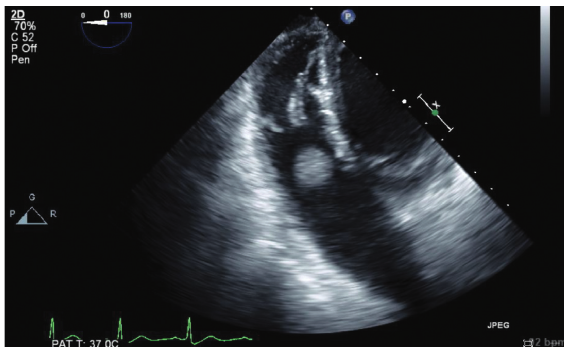
Figure 2: TEE-modified deep transgastric view: tip of the mass is seen at the body of the right ventricle below the tricuspid valve.